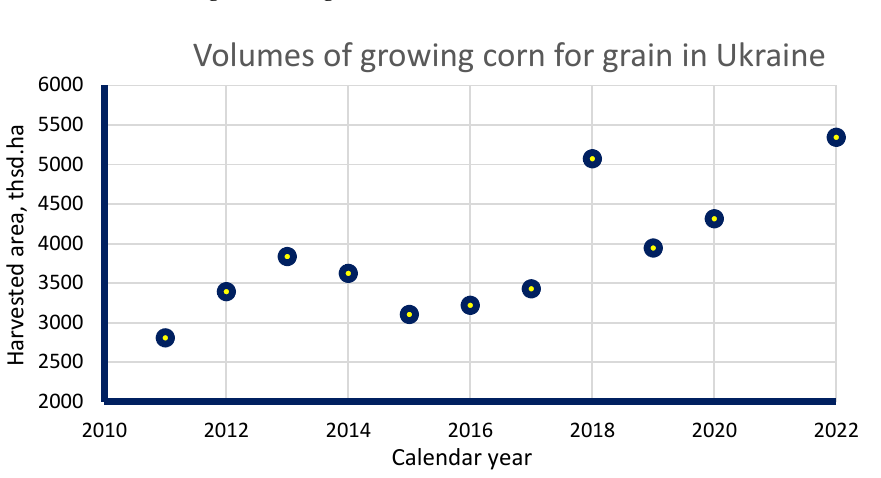
Figure 3. Trends in changes in the amount of corn grown for grain in Ukraine. Taking into account the above, the production of ecologically clean energy from corn waste was chosen for further